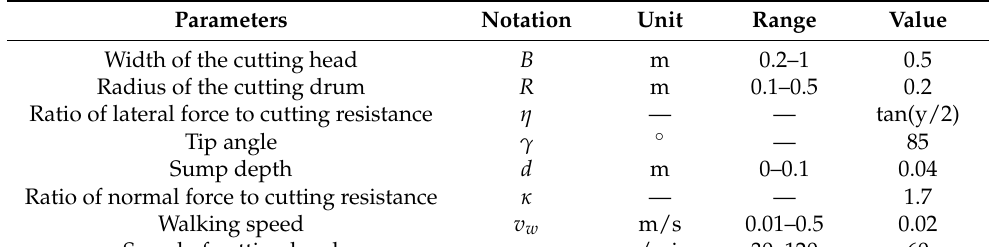
Table 2. Parameters of the cutting head.